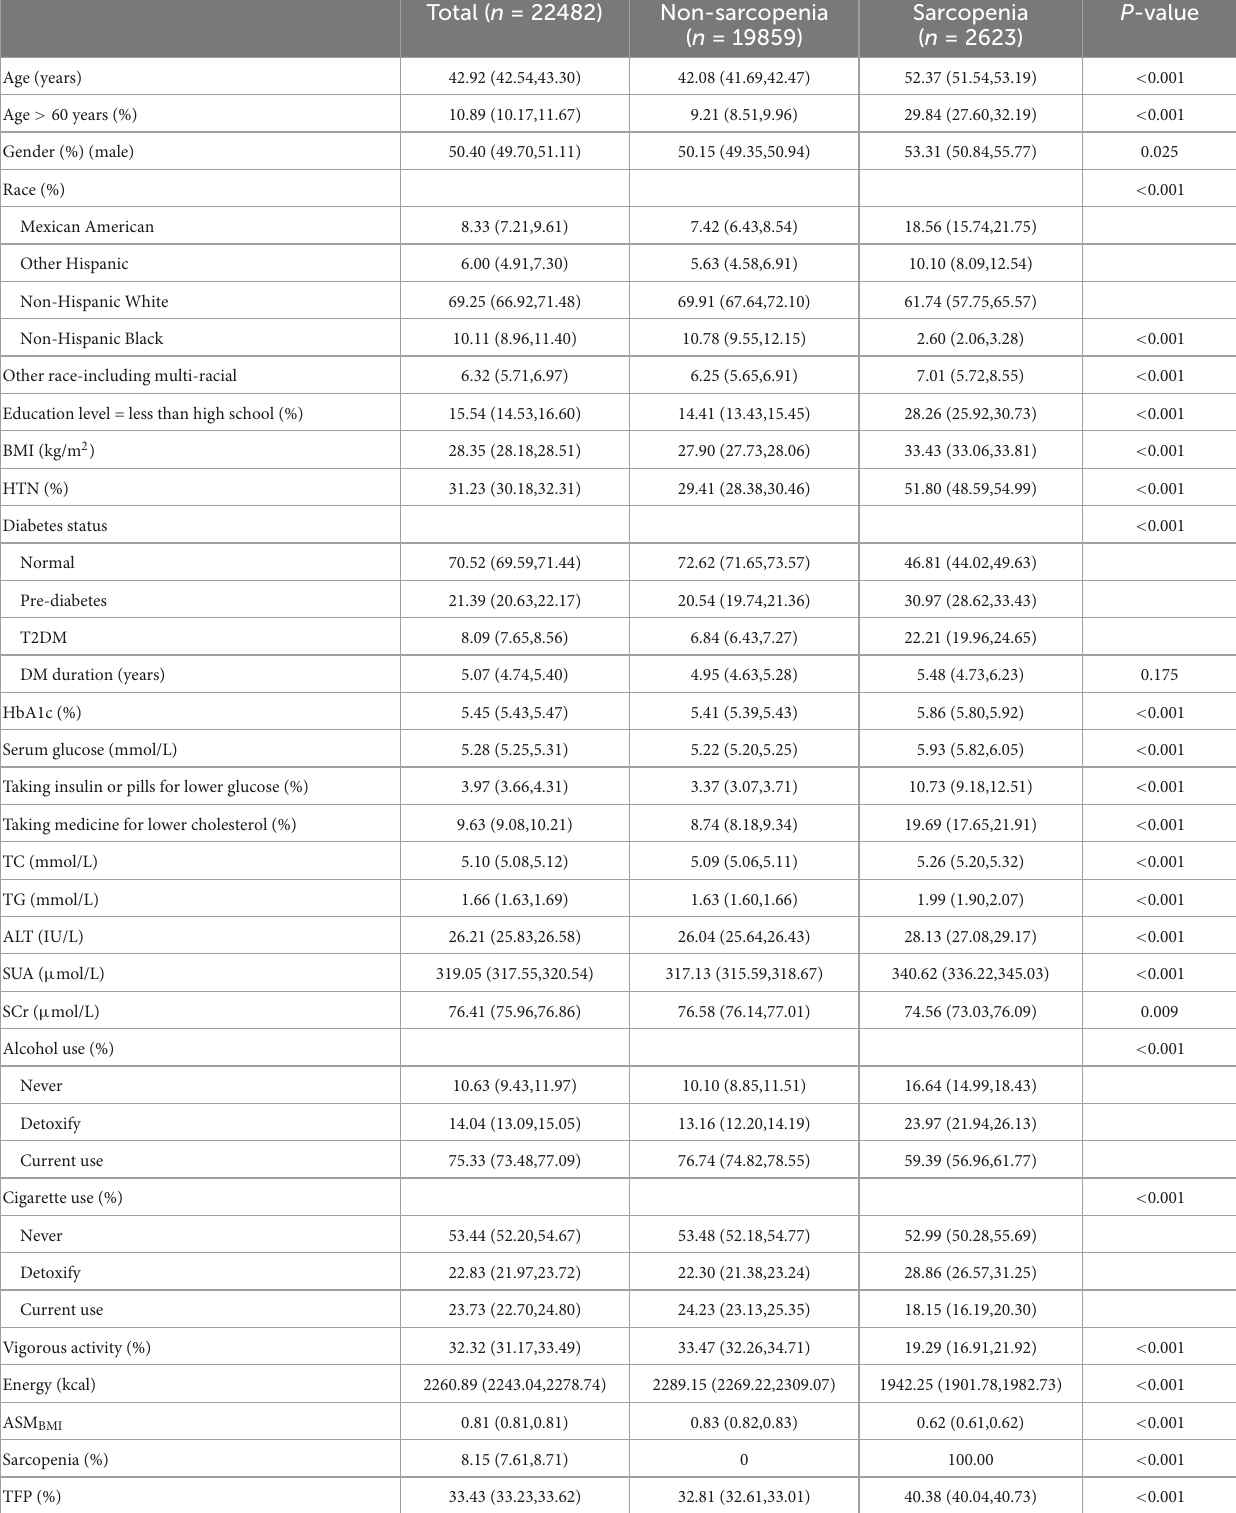
TABLE 1 Baseline weighted characteristics of the population included in the study.